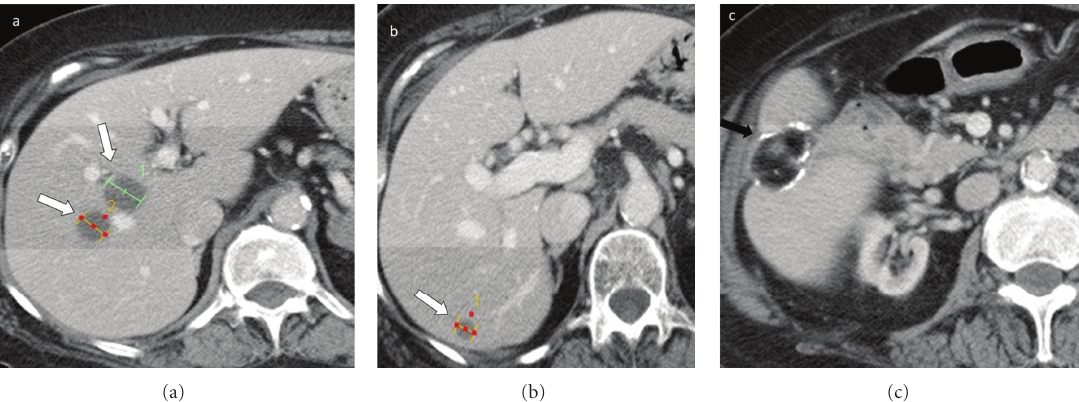
Figure 1: Contrast enhanced CT scan images demonstrate low attenuation right hepatic lobe lesions consistent with known metastatic disease (white arrows, (a) and (b)). Patient is status post partial segmental resection of the right hepatic lobe (black arrow, (c)).